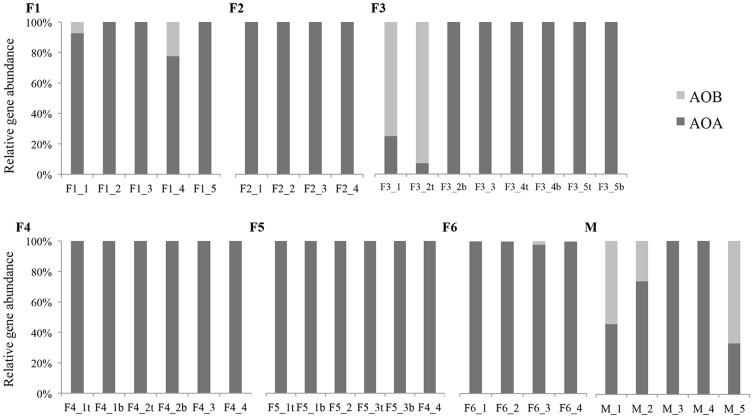
Relative amoA gene abundance of Thaumarchaea and Bacteria in sampled freshwater (F1–F6) and marine (M) aquaria, assuming 1 and 2.5 copies of amoA gene per thaumarchaeal and bacterial cell, respectively.